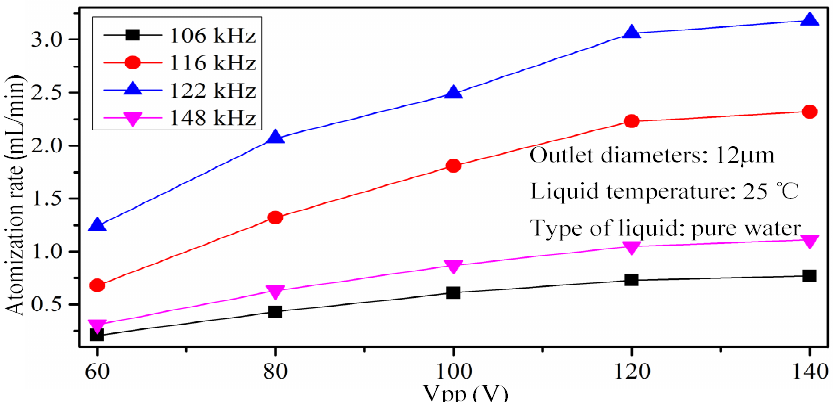
Figure 10. Relationship between the atomization rate and frequency.